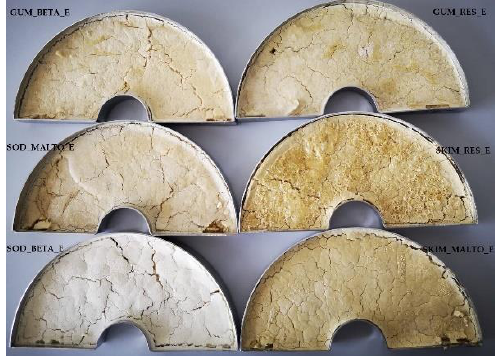
Figure 1. Samples of freeze-dried powders after freeze-drying.